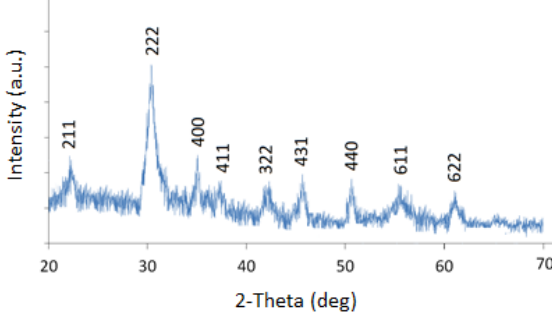
Figure 5. XRD analysis of the synthesized In 2 O 3 nanoparticles.